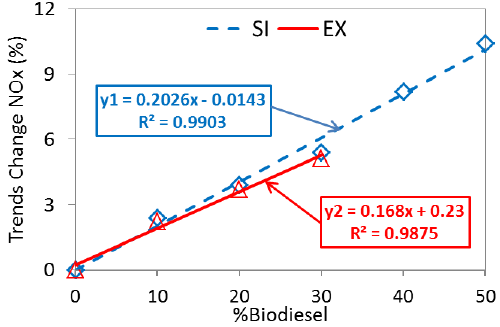
Figure 17. Trend of changes NOx emissions according to biodiesel blend ratio of simulation (SI) and experiment (EX).